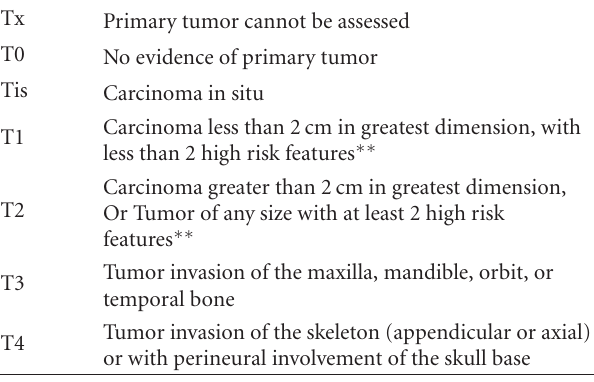
Table 2: Primary tumor (T) ∗